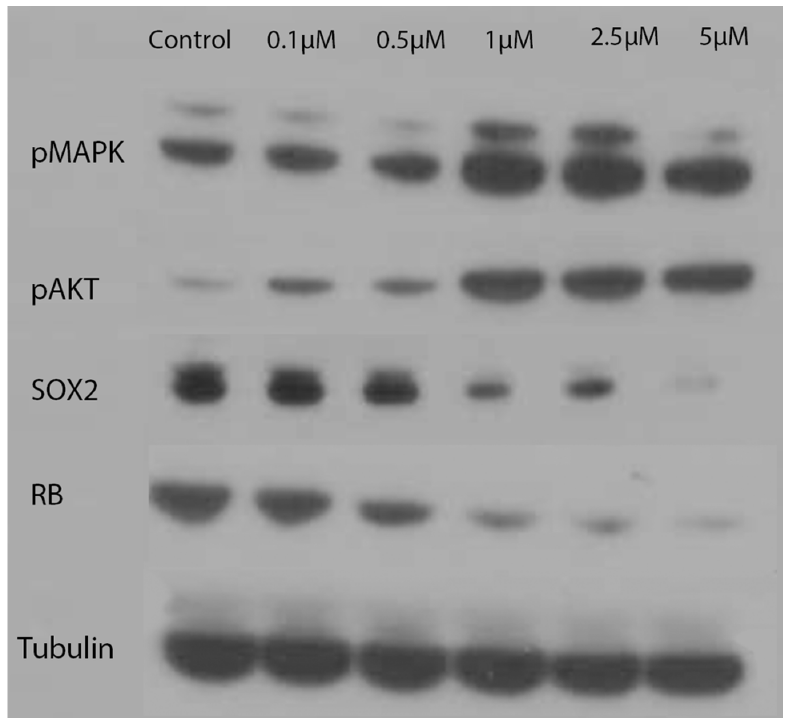
Figure 6. Western Blotting: Levels of pMAPK, pAKT, SOX2, RB, and Tubulin with concentrations of indolium 1 treatment. Tubulin serves as a loading control. LM36R cells were treated with a dose response for 24 h.